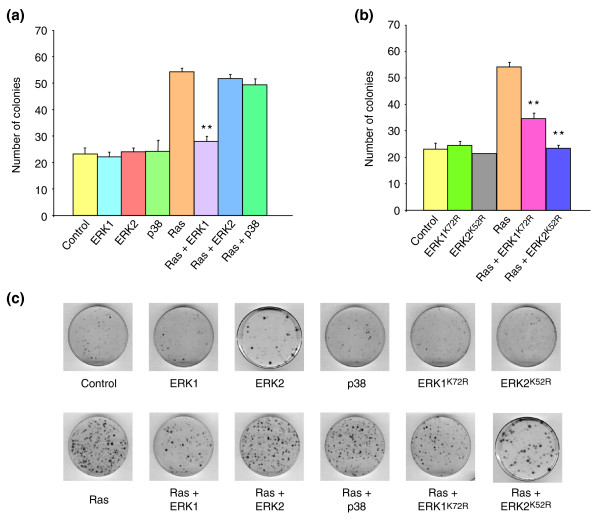
Ectopic expression of ERK1 in NIH 3T3 cells inhibits Ras-mediated colony formation. (a,b) NIH 3T3 cells were transfected as indicated and colony formation was scored after 10 days. Graphs represent quantitations of six independent experiments, expressed as mean ± SEM. Double asterisk indicates a genotype effect that is statistically significant (p < 0.0001), calculated from a post-hoc comparison in one-way ANOVA (Scheffe's test: RasQ61L-ERK1 versus RasQ61L-pMex; RasQ61L-ERK1K72R versus RasQ61L-pMex; RasQ61L-ERK2K52R versus RasQ61L-pMex). (c) A representative plate for each clone from (a,b) is shown.